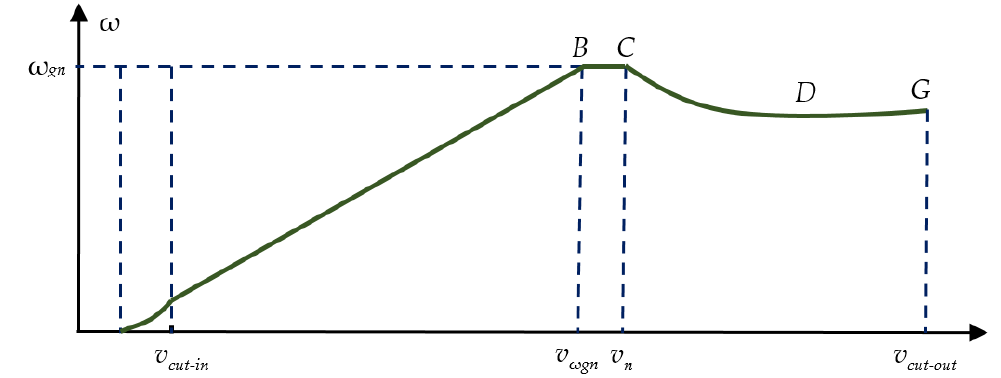
Figure 4. Typical characteristic of the rotor velocity versus the wind speed over the operating regions marked in Figure 3 for a variable-speed fixed-pitch (VSFP) WT.